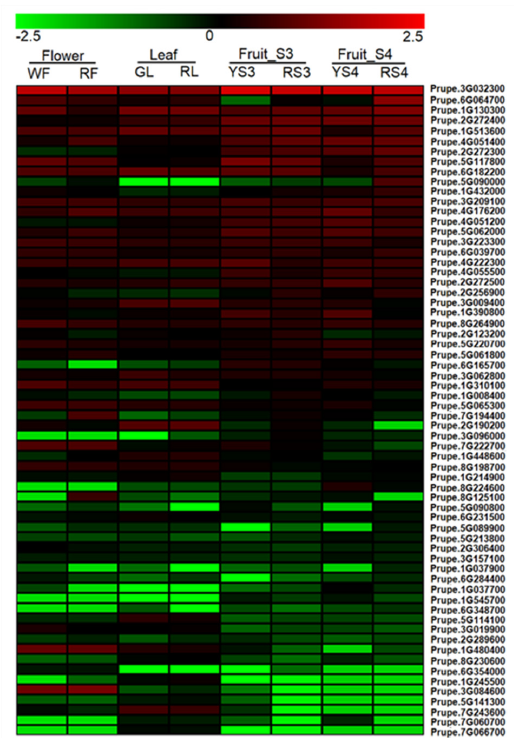
Figure 1. Heatmap of ethylene response factor ( ERF) genes in the transcriptomes of different peach tissues. Red and green boxes indicate high- and low-expression levels, respectively. WF, white flower; RF, red flower; GL, green leaf; RL, red leaf; YS3, yellow-fleshed fruit at S3; RS3, red-fleshed fruit at S3; YS4, yellow-fleshed fruit at S4; RS4, red-fleshed fruit at S4. S3 and S4 represent the second exponential growth phase and ripening stage, respectively.